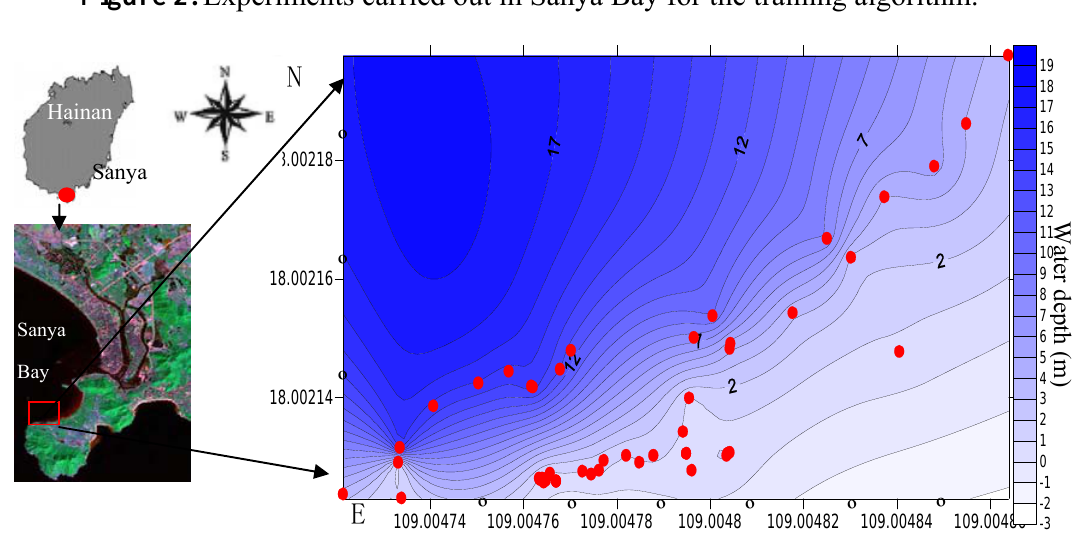
Figure 2. Experiments carried out in Sanya Bay for the training